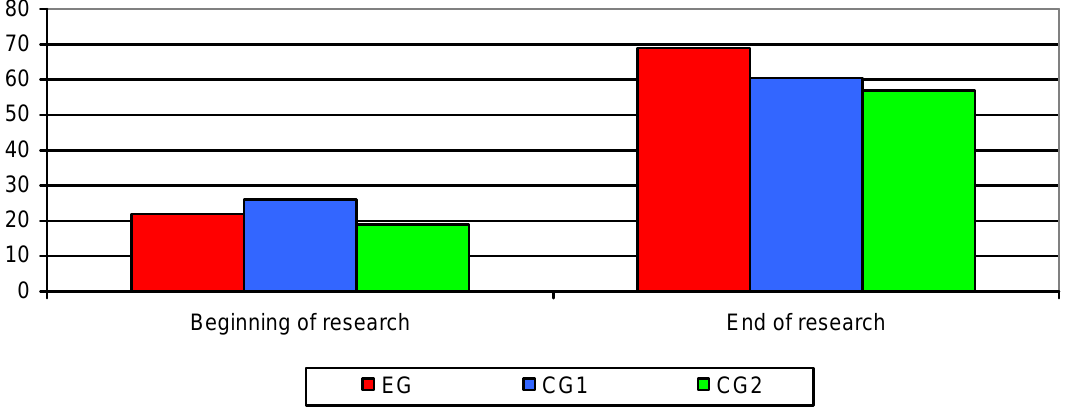
Fig.1 Dynamic of theoretical-methodological preparedness of students